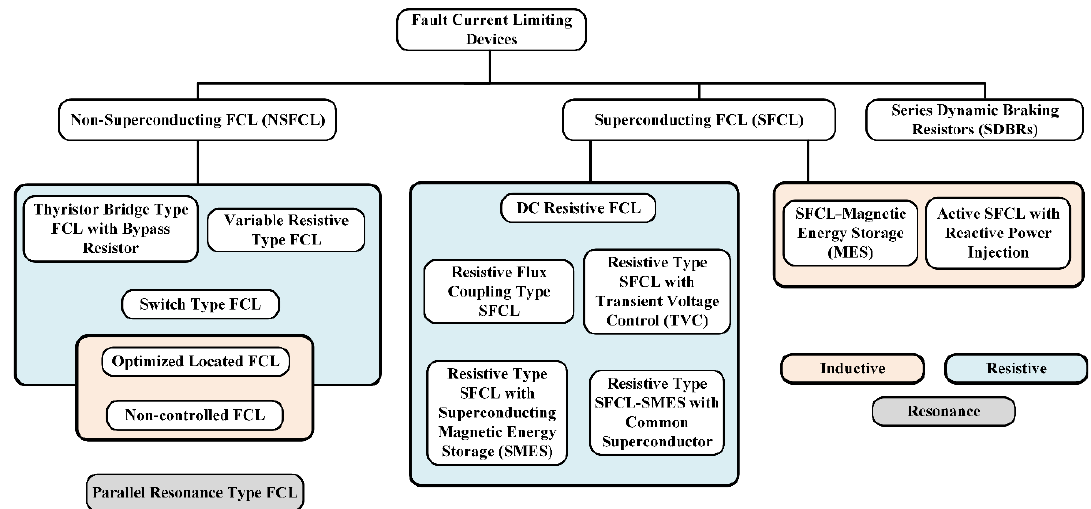
Figure 2. Diagram of the fault ride-through (FRT) capability enhancement by fault current limiting devices in the doubly-fed induction generator. FCL: Fault current limiter.